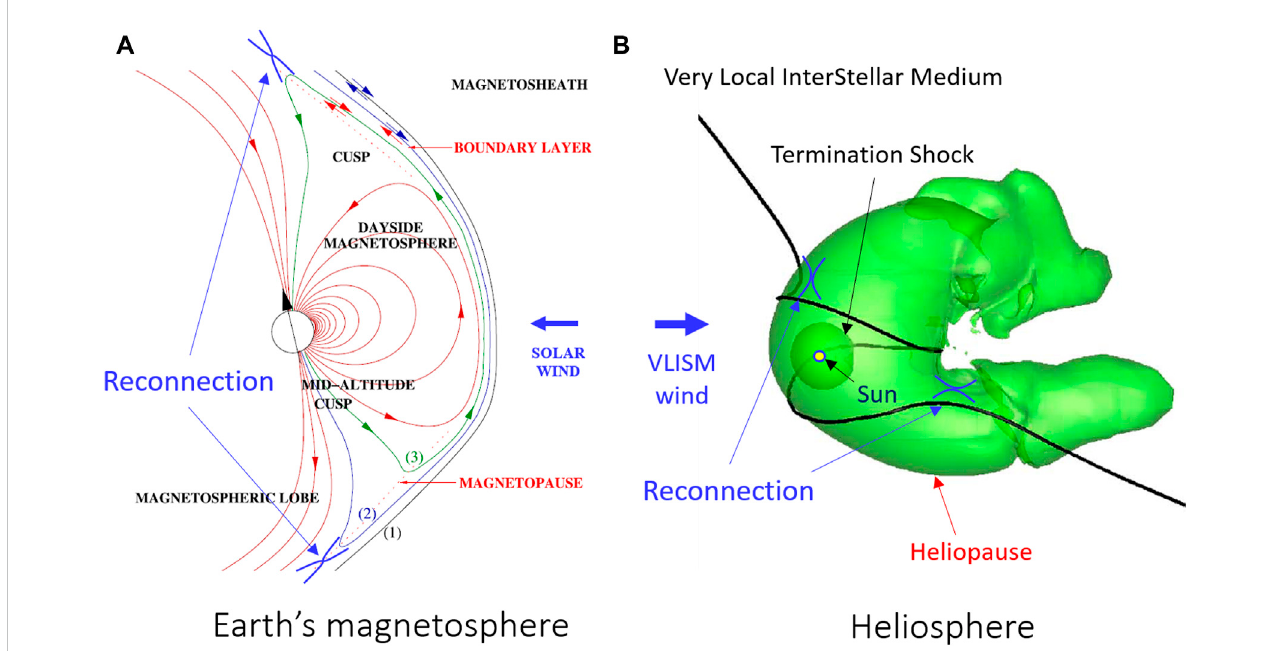
FIGURE 1 (A) Earth ’ s dayside topology when magnetic fi elds are parallel at the nose of the magnetosphere, leading to complex boundary layers inside (cusp) and outside (magnetosheath) the magnetopause (red dotted line) as a result of reconnection occurring twice and sequentially on the same magnetic fi eld line. Blue arrows adjacent to fi eld lines (1) and (2) illustrate the presence and direction of streaming, cold solar wind electrons. Red arrows, on fi eld lines (2) and (3), correspond to streaming heated electrons. Field line (1) is a pristine fi eld line open to the solar wind at both ends. Field line (2) is a fi eld line which has reconnectedin only one hemisphere. Field line (3) has reconnected in both hemispheres. Adaptedfrom Lavraud et al. (2006) (B) MHD simulation result of the heliosphericinteractionwiththeVeryLocalInterstellarMedium(VLISM).Theheliopauseisapproximatedwithanisocontourintemperature(greenshading).A magnetic fi eld lines is shown inblack. It results from double reconnection of aVLISM fi eld line (straight extensions of the fi eld line to the top and bottom)with the wound fi eld (spiral) of the heliosphere. Adapted from Opher et al.